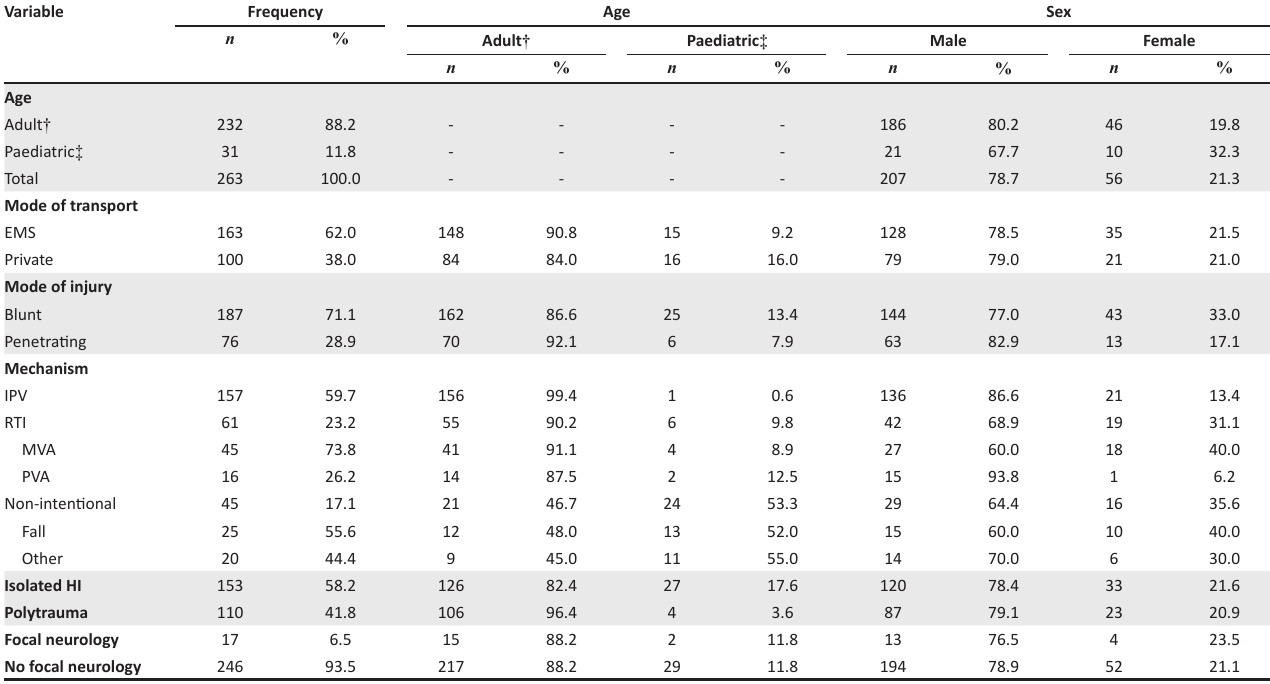
TABLE 1: Demographics according to age and gender distribution ( n = 263). Variable